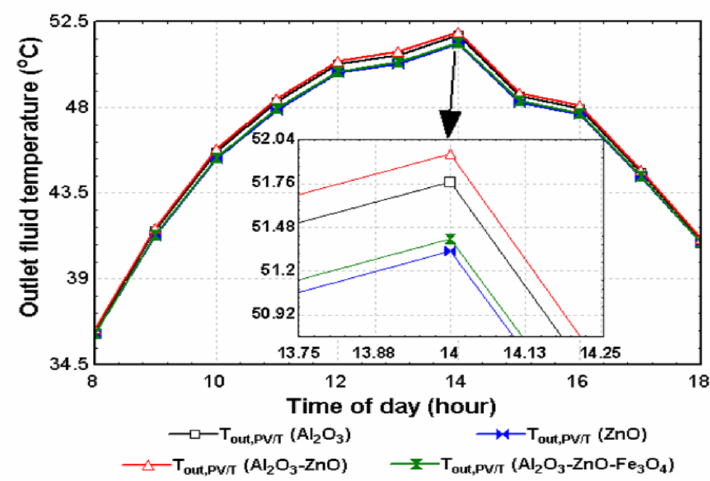
Figure 10. Numerical result of PV/T outlet temperature.